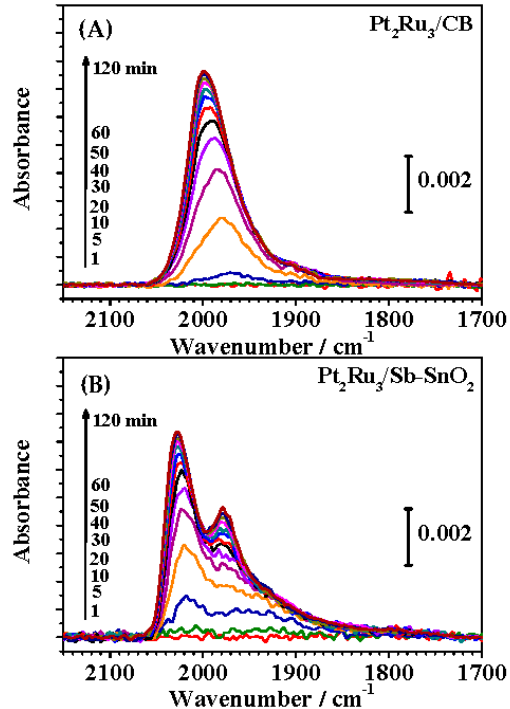
Figure 5. Changes in FTIR spectra observed on Nafion-coated ( A ) Pt 2 Ru 3 /CB and ( B ) Pt 2 Ru 3 /Sb-SnO 2 electrodes at 0.02 V and 60 °C during CO adsorption in 0.1 M HClO 4 with bubbling 1% CO (H 2 balance) for 120 min.